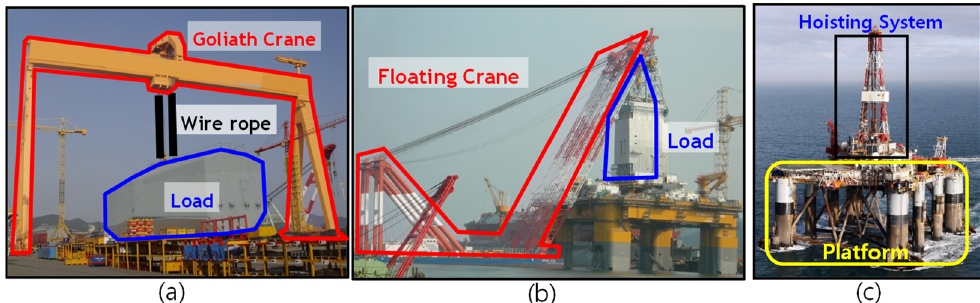
Figure 1. Various types of mechanical systems in the shipbuilding industry; ( a ) goliath crane; ( b ) floating crane; and ( c ) offshore drilling rig.